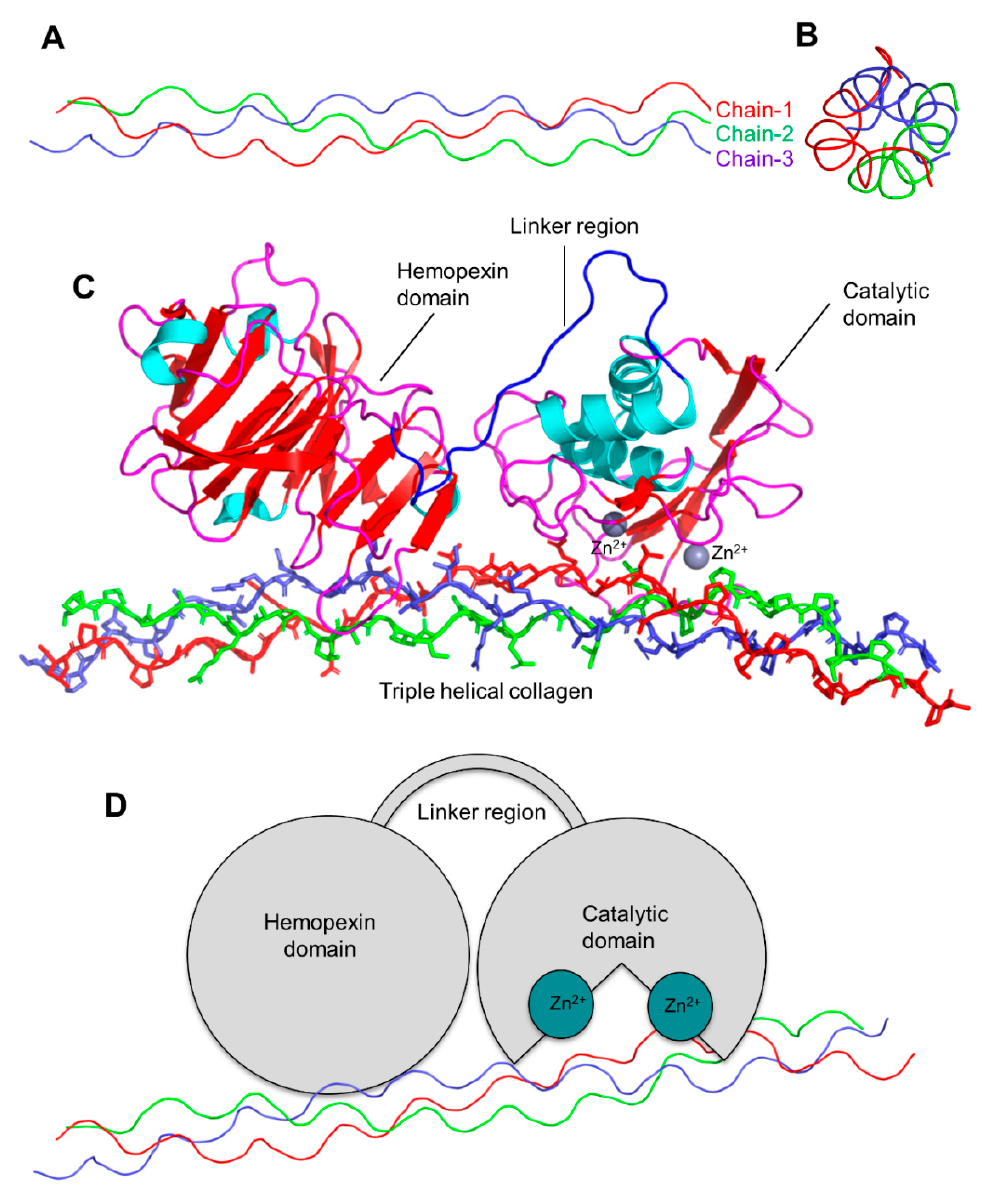
Figure 3. The 3D structure of collagen type-1, three chains are highlighted in red, blue, and green (triple-helical), side view ( A ), front view ( B ), 3D representation of MMP-1 (cartoon view) interacting with triple helical collagen (domain representation) ( C ), domain schematic representation of the MMP-1 interacting with collagen ( D ).